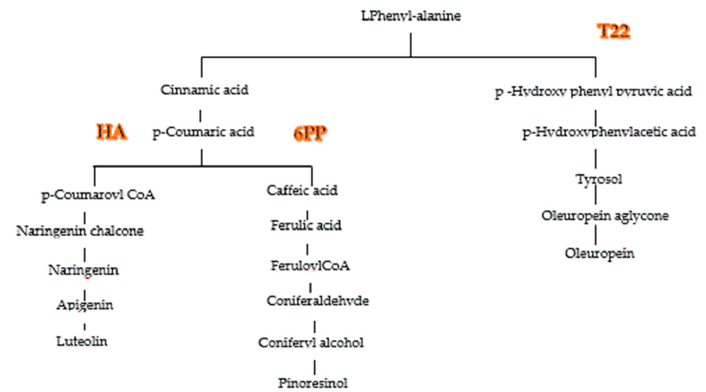
Figure 8. I nterferences of Trichoderma T22 and its metabolites (HA and 6PP) on Shikimate pathway